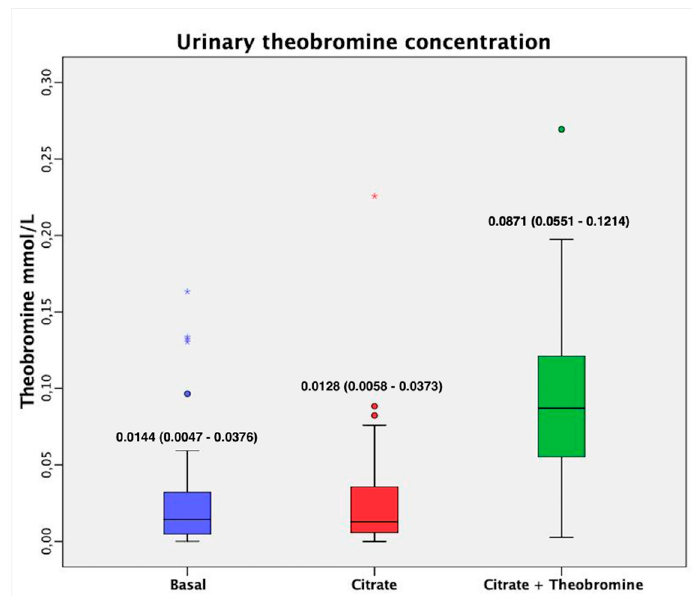
Figure 4. Urinary theobromine concentration before and after both treatments. Values are expressed as median (interquartile range). The dark lines in the boxes are the medians. The bottom and the top of the box indicate the 25th and the 75th percentiles, respectively. The T-bars that extend from the boxes are the inner fences. These values are indicated on each box. The points are outliers and the asterisks are extreme outliers. (a) p < 0.001 vs. basal value. (b) p < 0.001 vs. after citrate treatment.